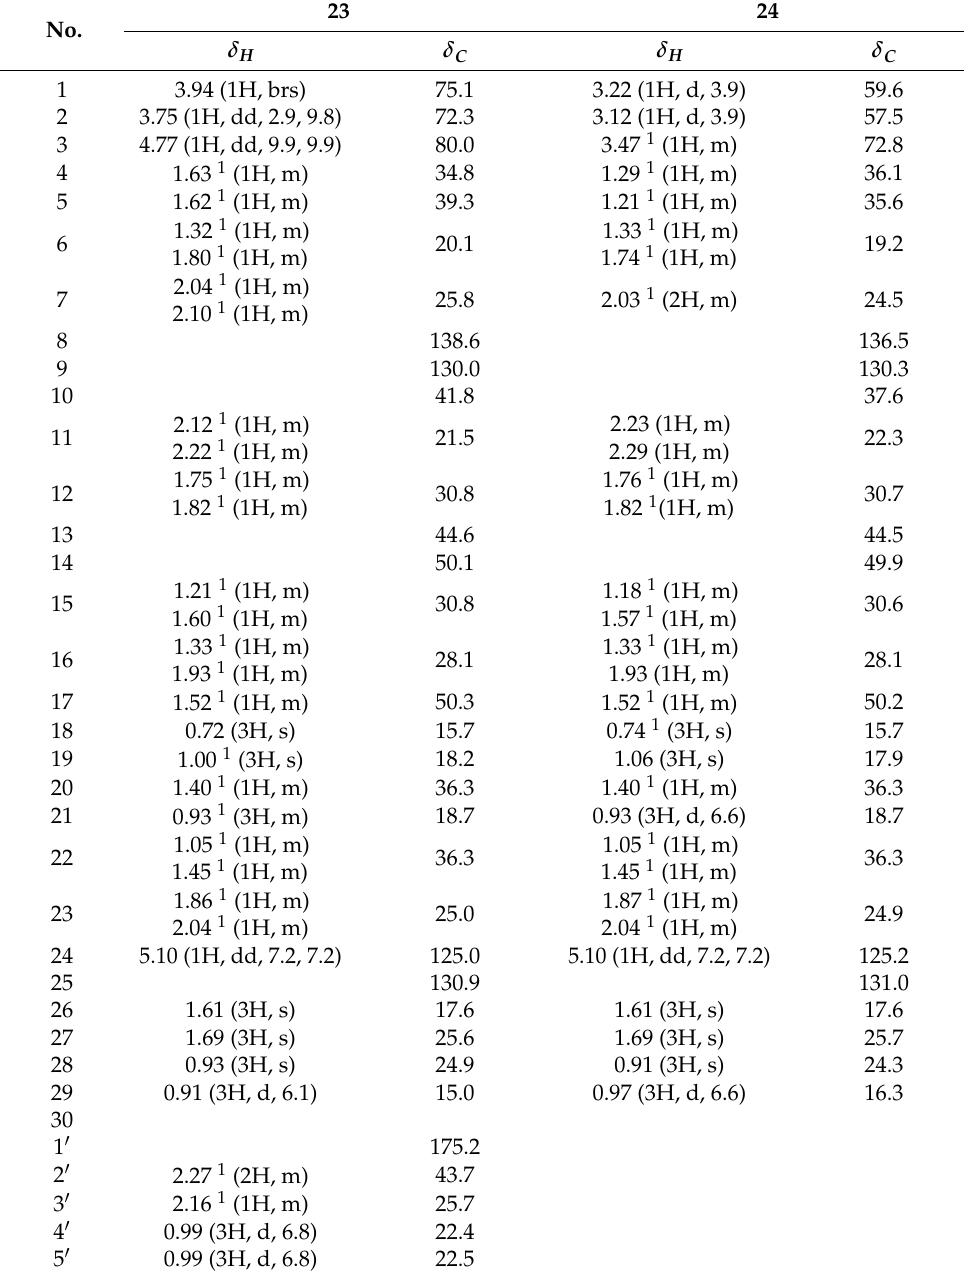
Table 4. 1 H and 13 C NMR data for compounds 23 and 24 (600 and 150 MHz, respectively) in CDCl 3 ( δ in ppm, J in Hz, s: singlet, d: doublet, br: broad, and m: multiplet).